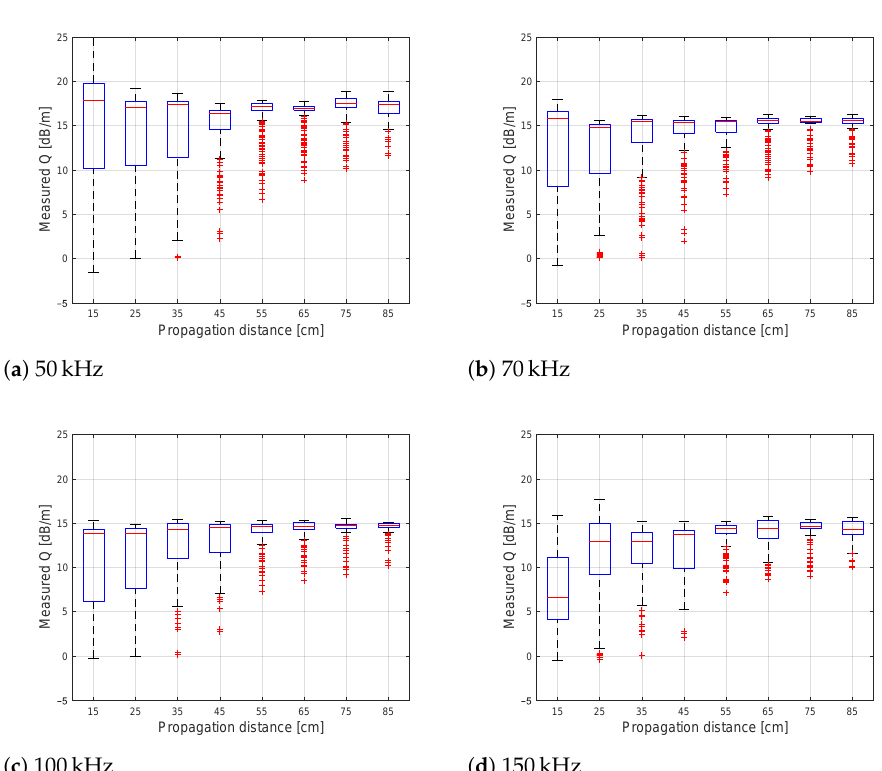
Figure A3. Estimated and sorted attenuation rates Q along the water-sand transition. The data con- tains all measured circumferential FA-L(0,1) of ring number one and the four excitation frequencies. The data is sorted and selected as blocks according to the propagation distance of each arrival.